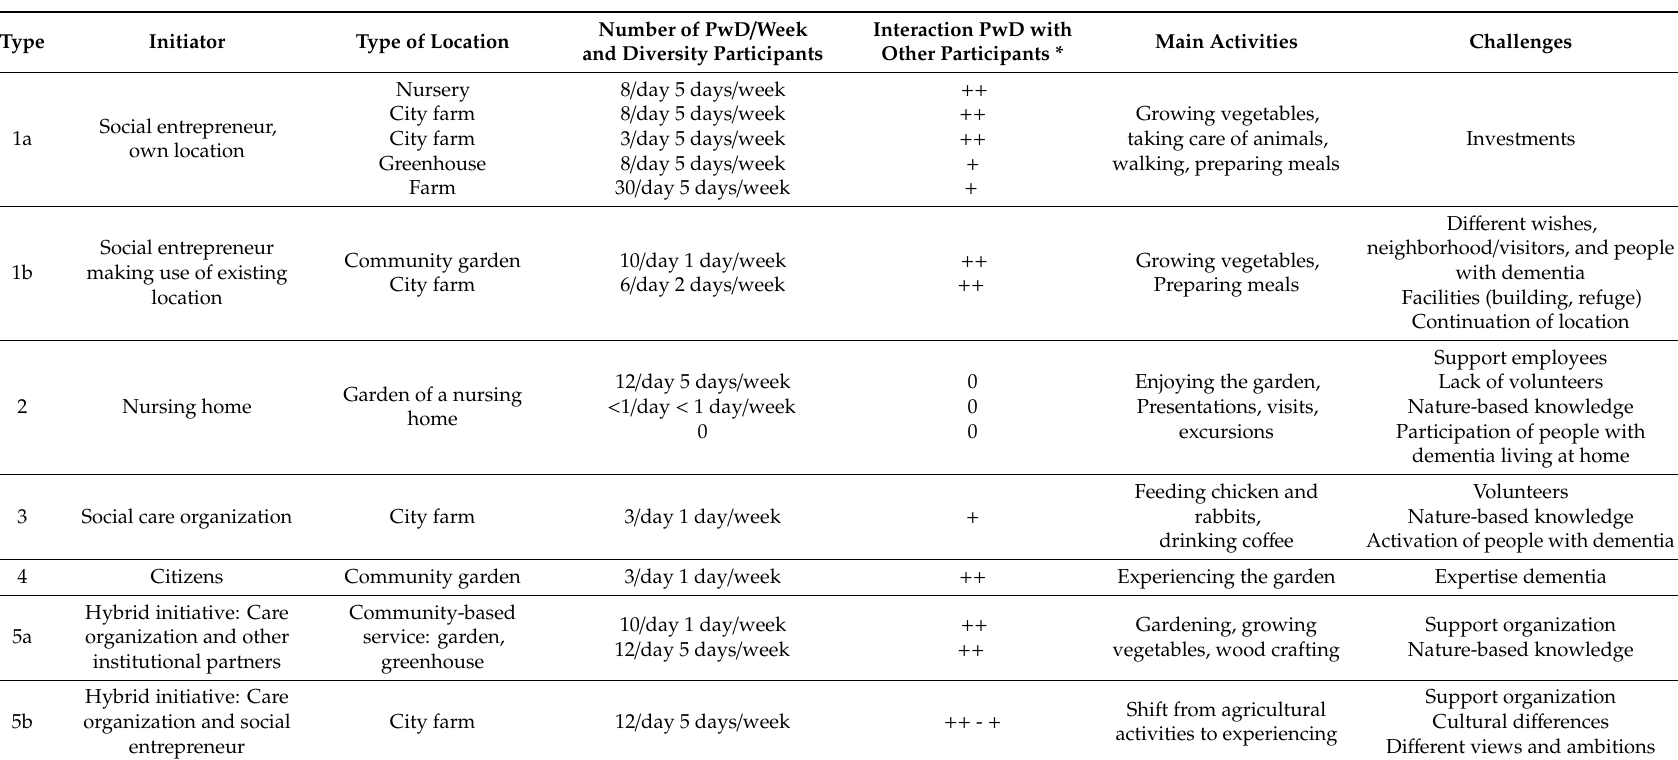
Table 1. Characteristics of the 15 nature-based day services for people with dementia (PwD) in urban